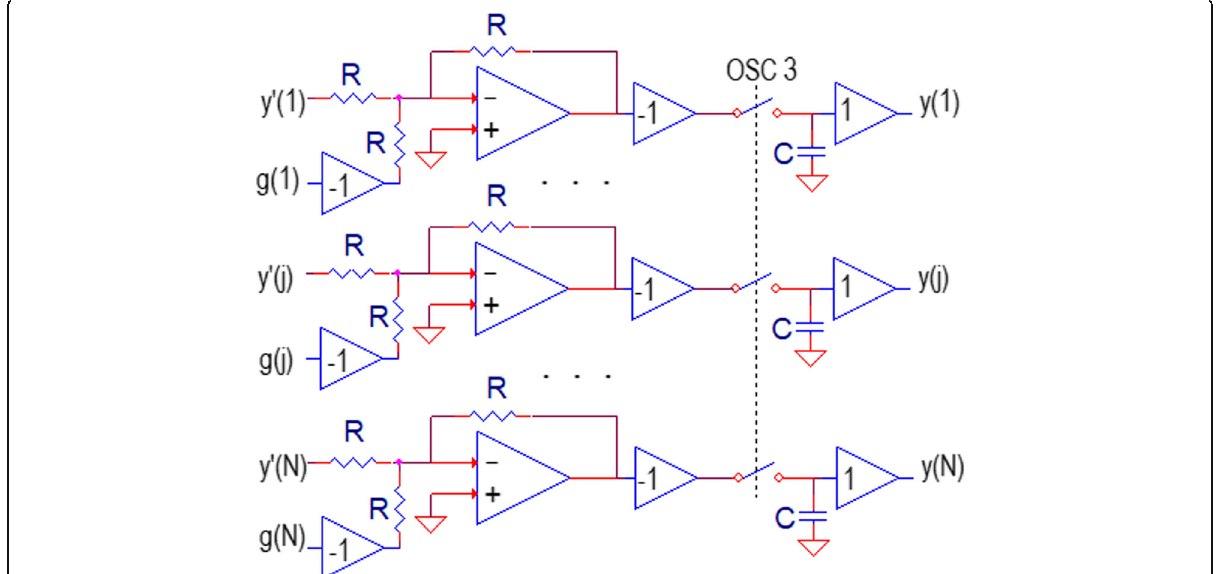
Fig. 7 Circuits for updating the input signal values